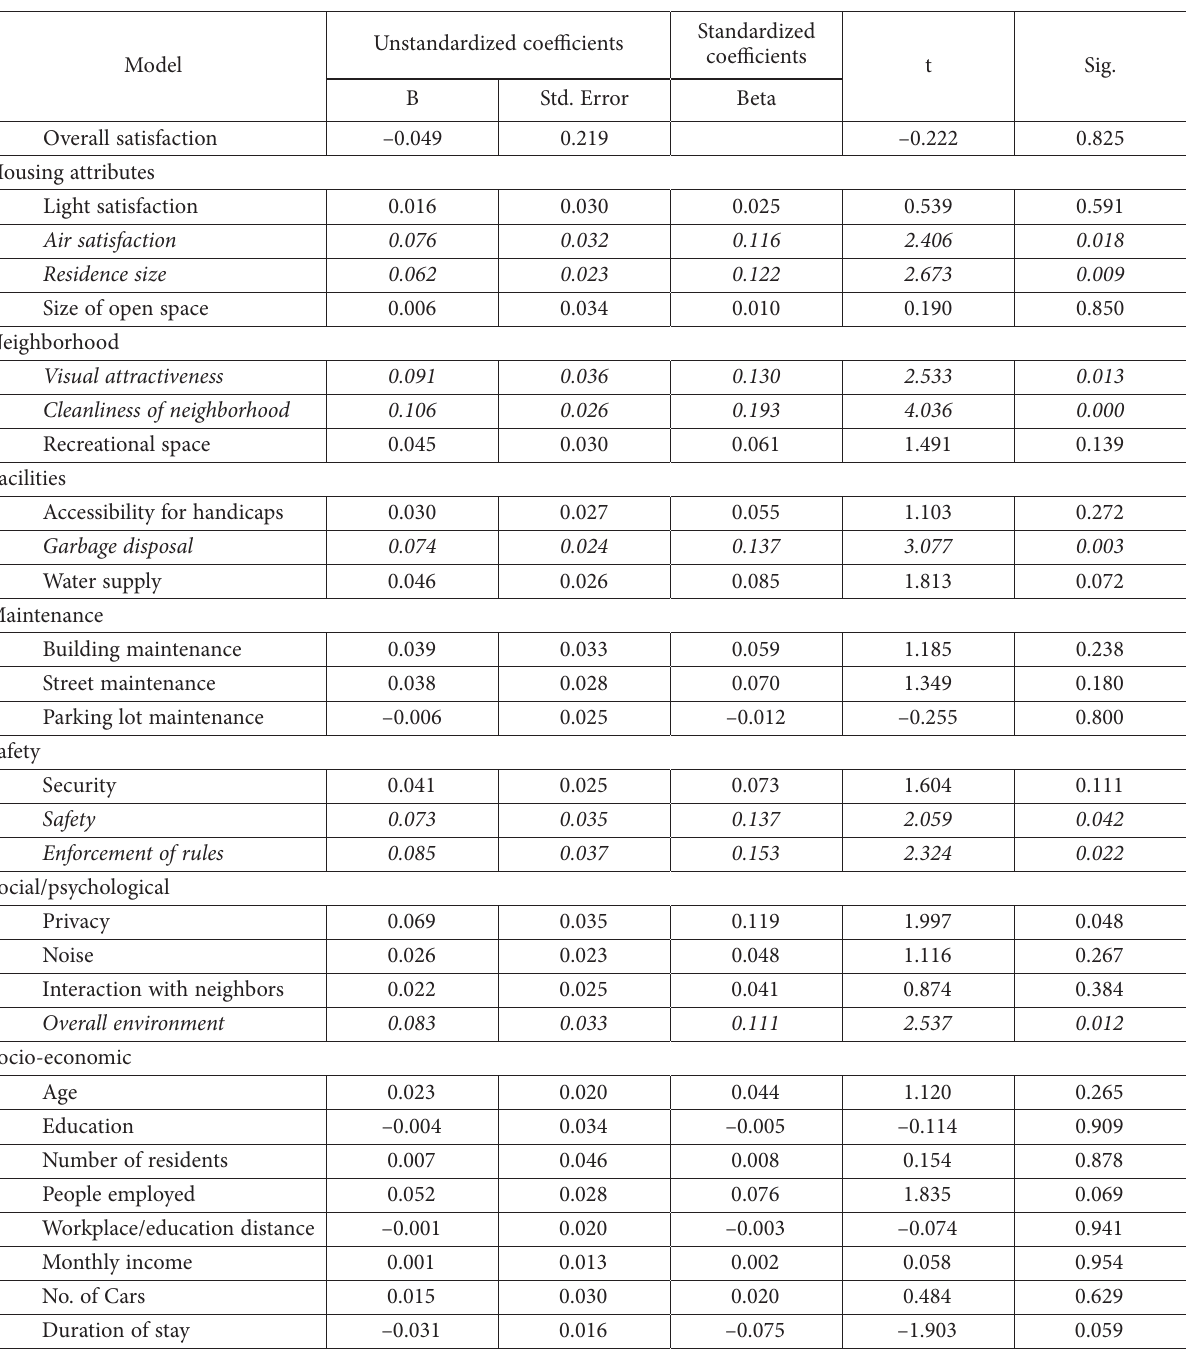
Table 6. Regression analysis for overall residence